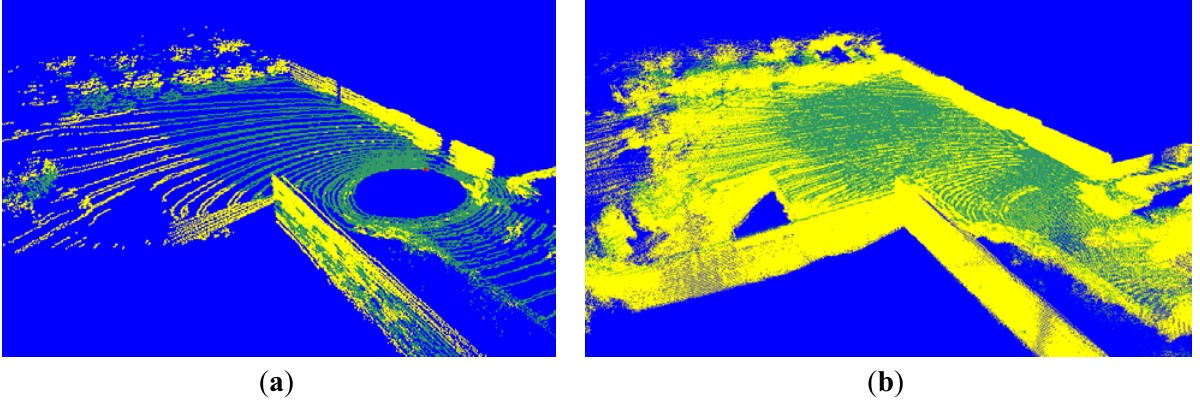
Figure 10. Segmentation results. ( a ) Segmentation result from 88,536 voxels. ( b ) Segmentation result from 1,817,035 voxels.